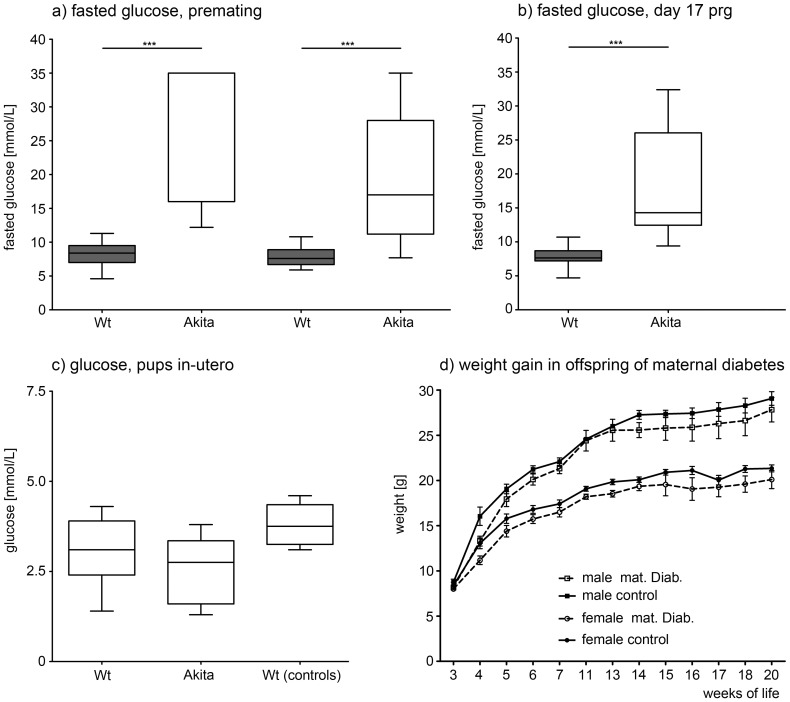
Premating and Pregnancy Glucose Values.Boxplots showing the smallest observation (lower bar), lower and upper quartile (box), median (line in the box) and largest observation (upper bar) of fasted serum glucose in mmol/L in a) WT and Akita males (n = 26 WT, 8 Akita) and females (n = 22 WT, 19 Akita) prior to mating, b) WT and Akita females on day 17 of pregnancy and c) wildtype (n = 10) and heterozygous (Akita) pups (n = 7) in-utero on day 17 of pregnancy and WT pups (n = 5) from control breedings on day 17 of pregnancy. *** indicate p<0.001 d) Weight gain from weaning to 20 weeks of life for male and female offspring of maternal diabetes and controls (mean weight in g ± SEM, n 8–15 per group). Offspring of diabetic mothers weighed less from weaning (for males: 8.16+0.9 g vs. 8.75+0.8 g in controls and for females: 8.0+0.6 g vs 8.4+1.0 g in controls) to sacrifice.